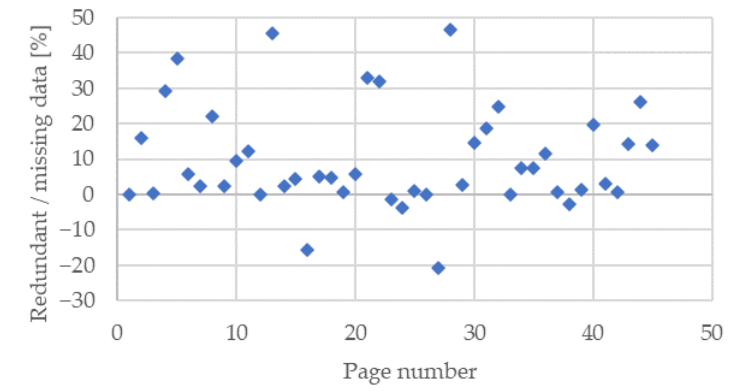
Figure 5. The graphical display of the results of the algorithm (comparison of the desired state with the output of the algorithm).